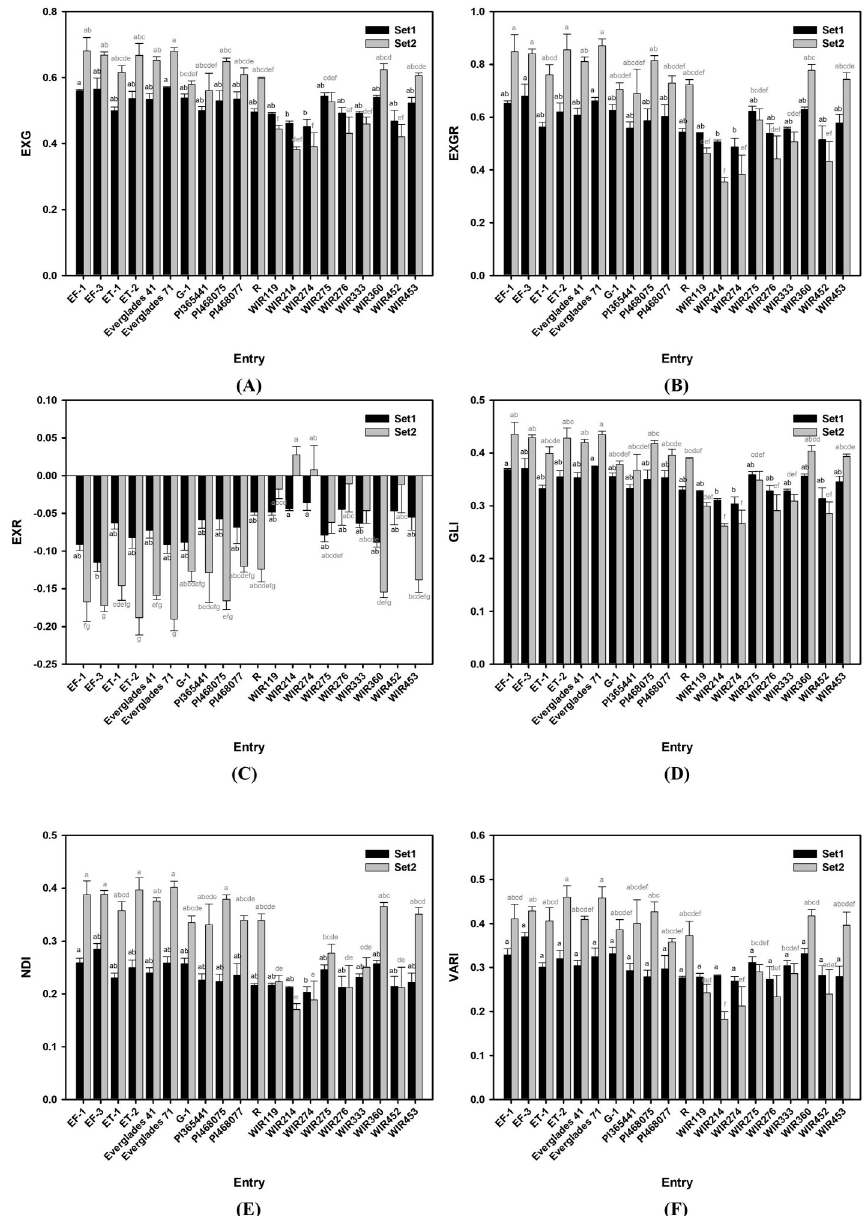
Fig 6. Variation of VIs among kenaf ( Hibiscus cannabinus L.) entry two growth stage. (A) EXG, (B) EXGR, (C) EXR, (D) GLI, (E) NDI, and (F) VARI of 20 kenaf cultivars at two different growth stages. Set 1 and Set 2 measured June 22 and August 31. The black bar and letter represent set 1, and the grey bar and letter represent set 2. Different letters on the bar are significantly different by Dunn test with Bonferroni adjustment. Non-parametric rank data were used for the statistical analysis; however, untransformed data are